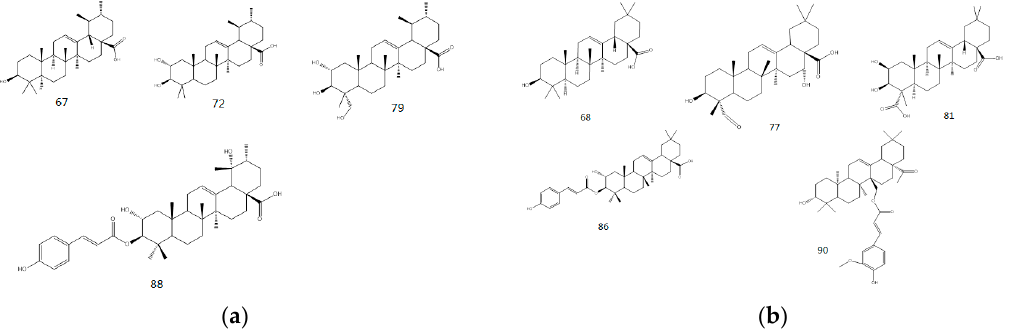
Figure 5. Structure of ursane-type ( 67 , 72 , 79 , 88 ) and oleanane-type ( 68 , 77 , 81 , 86 , 90 ) pentacyclic triterpene. This figure is fuzzy, please replace it with sharper figure.